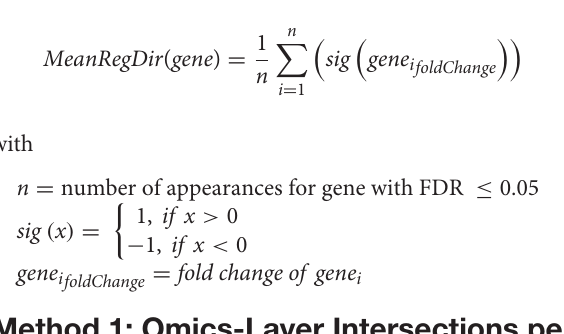
( Supplementary Presentation 2